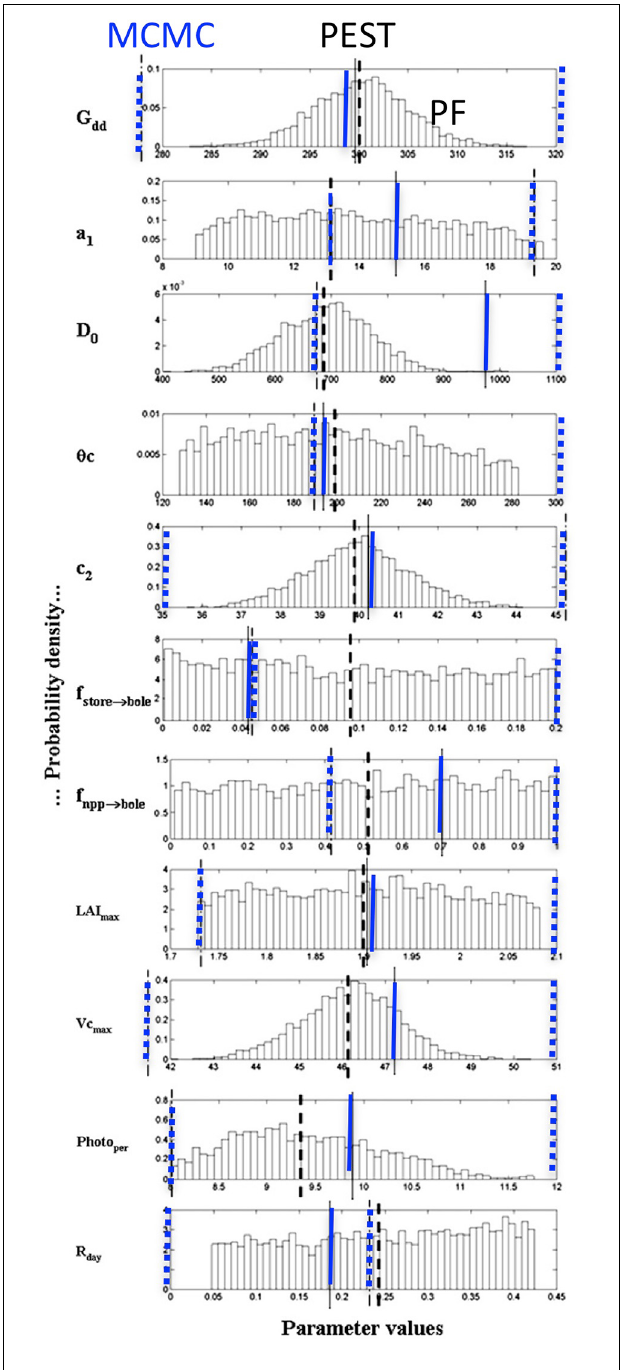
FIGURE 1 | The eleven MAIDEN parameter probability distributions using the particle filter technique for Pinus halepensis . The heavy black dashed lines indicate the PEST optimum parameter value, the blue dashed lines indicate the 5 and 95% percentiles, while the blue continuous lines show the MCMC parameter modes for comparison. Meaning of the abbreviations: G dd , Growing degree-days in C; a 1 , Leuning factor, linking stomatal conductance and photosynthesis; D o , coefficient linking the stomatal conductance and the humidity deficit at the leaf sur- face, in P a ; θ c , Soil water stress parameter, in mm; c 2 , Temperature function